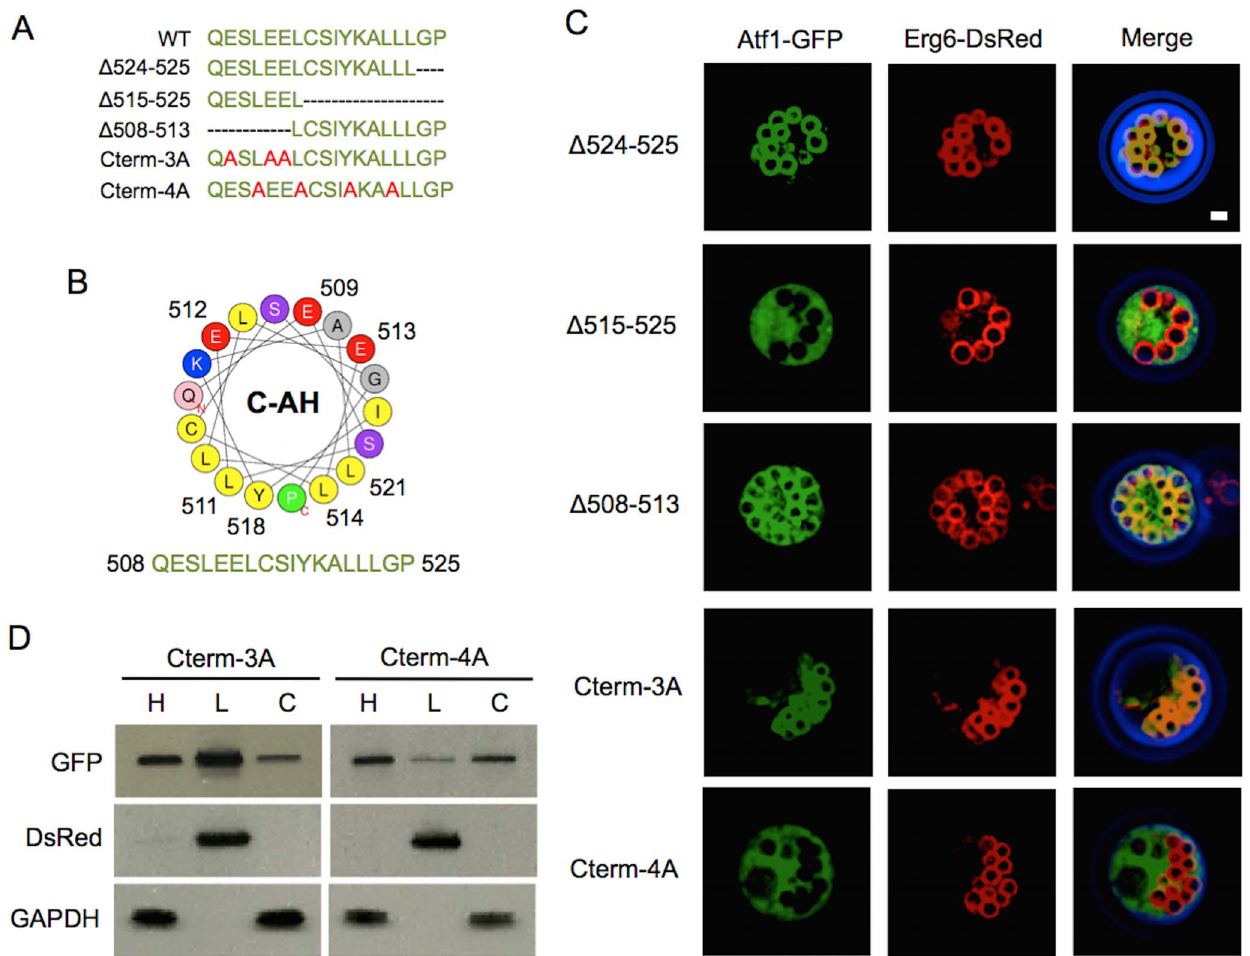
Figure 3. The C-terminal amphipathic helix of Atf1 is necessary for LD localization. (A) C-terminal sequences studied. Mutated residues shown in red and the amphipathic sequence shown in green. (B) Helical wheel projection of the C-terminal helix. Hydrophobic residues are colored yellow, neutral in gray, basic in blue, and acidic in red. The numbered basic residues were mutated to alanine in Nterm-3A and the numbered hydrophobic residues were mutated to alanine in Nterm-4A. (C) Fluorescent images of stationary phase cells overexpressing Atf1-GFP, truncates, and mutants with co-expression of the LD marker Erg6-DsRed. Truncation of residues 524–525 has no effect on LD localization while truncation of 515– 525 and deletion of 508–513 eliminate LD localization. Mutation of residues in Nterm-4A attenuates LD localization, while Cterm-3A has little effect on LD localization. Scale bar, 1 m m. Quantification of fluorescence microscopy was performed by counting a minimum of 300 cells from three independent experiments. LD localization was observed in 89 6 1% of D 524–525 expressing cells, while cells expressing D 515–525, D 508–513, Cterm- 3A, and Cterm-4A showed LD localizations of 0%, 8 6 2%, 84 6 4%, and 0%, respectively. (D) Western blot analysis of cell homogenates (H), and LD (L) and cytosolic (C) cell fractions. Erg6-DsRed was used as a LD marker and GAPDH was used as a cytosolic protein